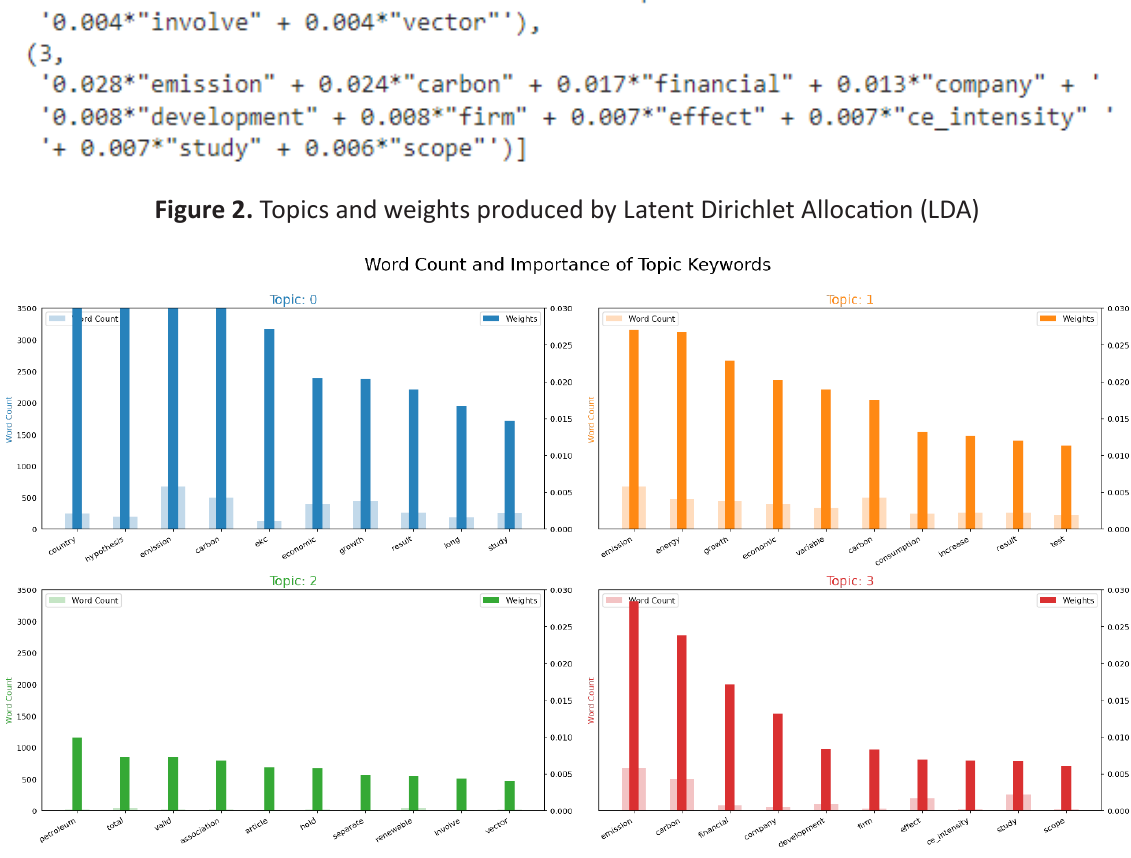
Figure 3. Topic keywords in terms of their importance